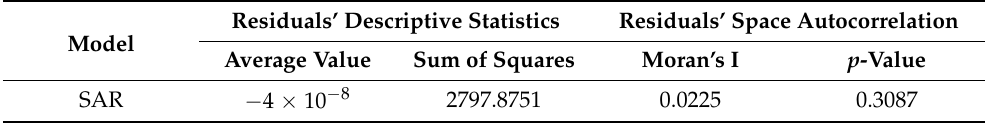
Table 1. Fitting performance for spatial variables.